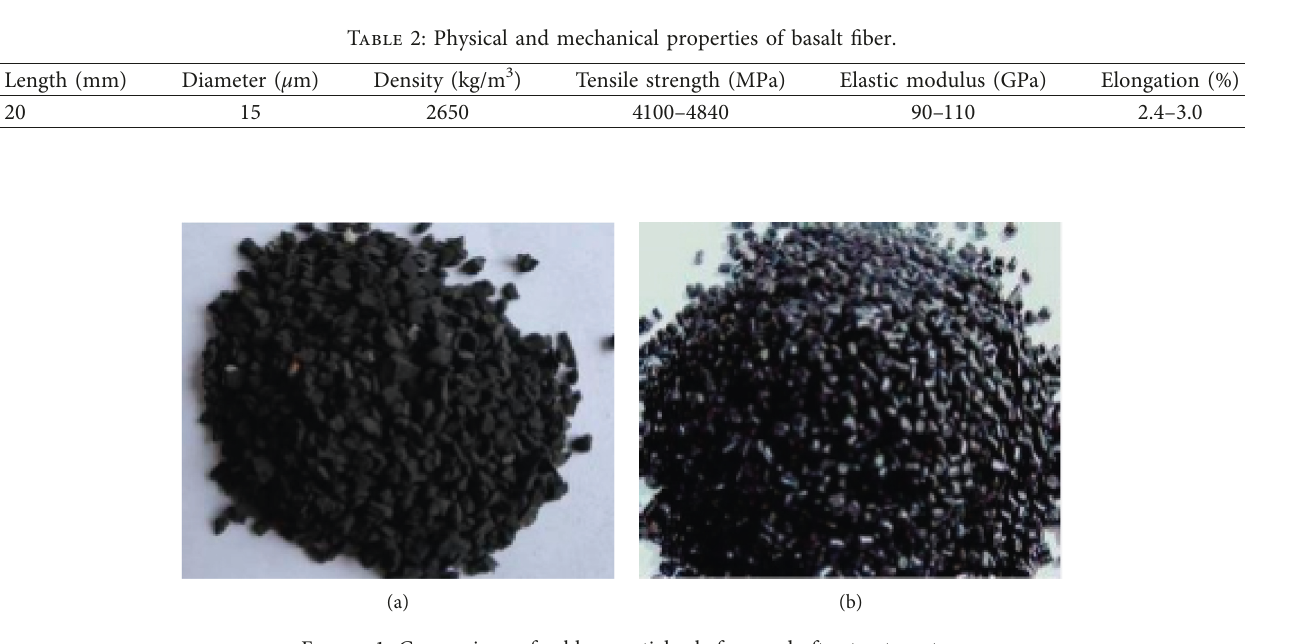
Figure 1: Comparison of rubber particles before and after treatment. Table 3: Mixture proportion of basalt fiber rubber mortar (by